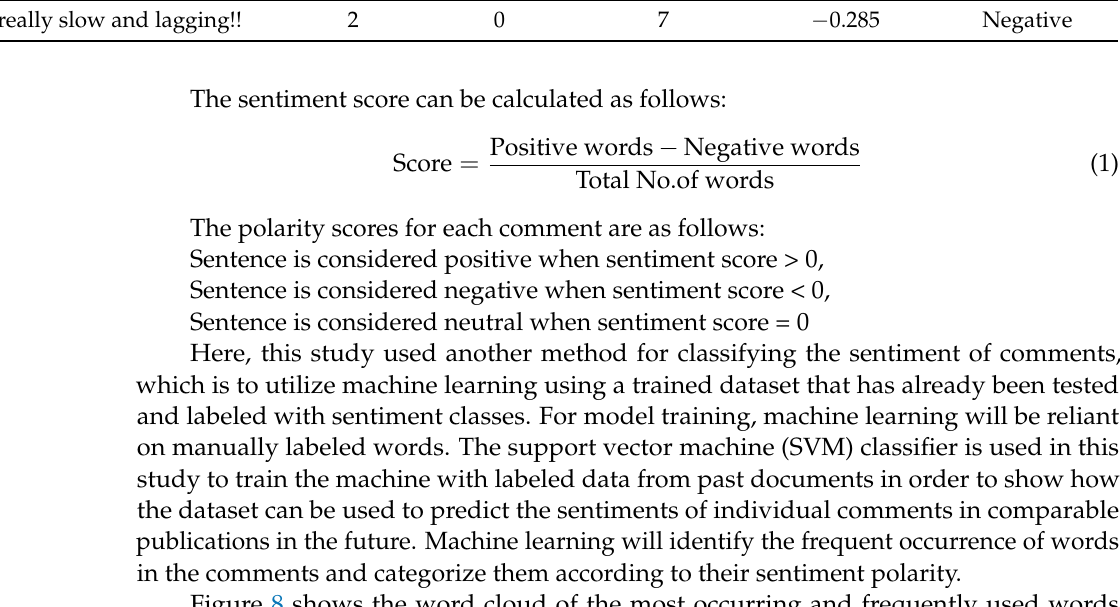
Figure 9. Word cloud stemming. The word cloud can be included as a training data for classification training, how- ever, it may not be necessary. The machine learning sentiment classification workflow is depicted in Figure 10. It is also critical to train the machine to learn on a regular basis, utilizing a variety of datasets created by the user or downloaded from the internet, to ensure that the sentiment categorization is always up to date, and that the sentiment score is accurate.